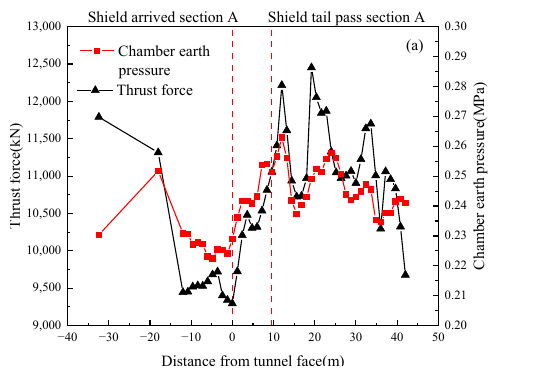
Figure 13. Measured values of thrust force and chamber earth pressure: ( a ) south line; ( b ) north line.